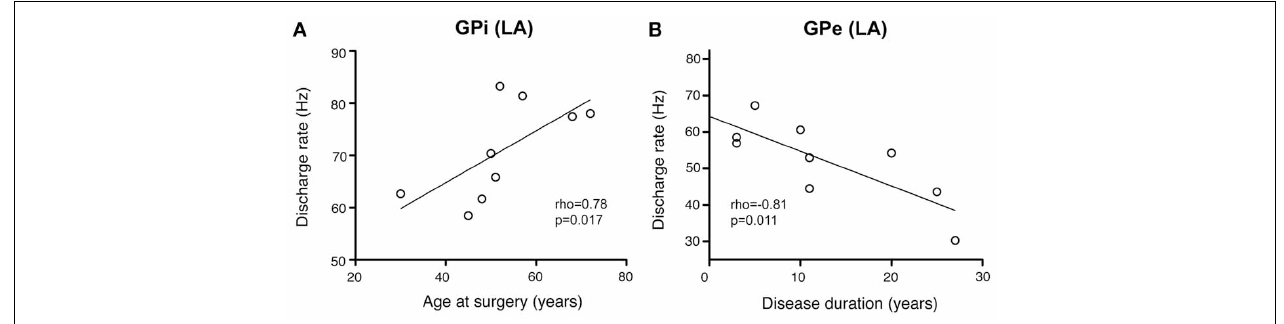
hemispheres). (A) Average firing rate of GPi neurons showed a significant positive correlation with mean age at time of DBS surgery. (B) Mean GPe discharge rates were correlated inversely with disease duration.